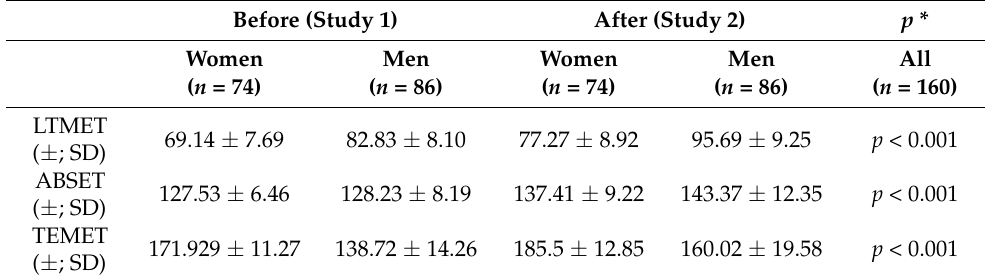
Table 3. Results of the core stability tests before and after core stability training program.